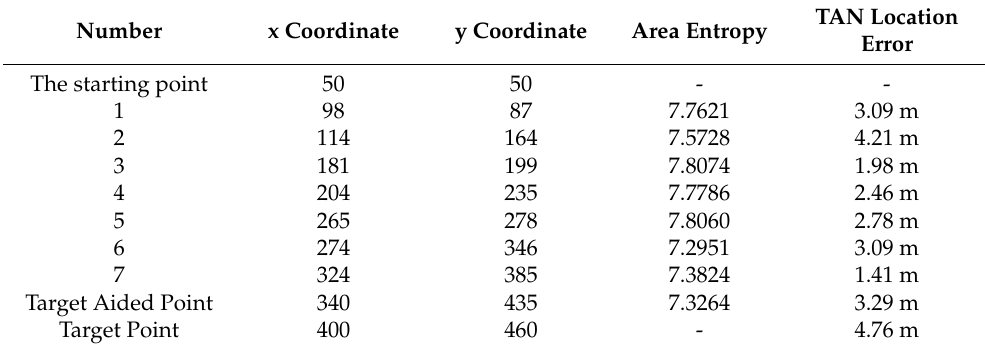
Table 8. Data of each point searched on the route of the second group of starting and ending points.